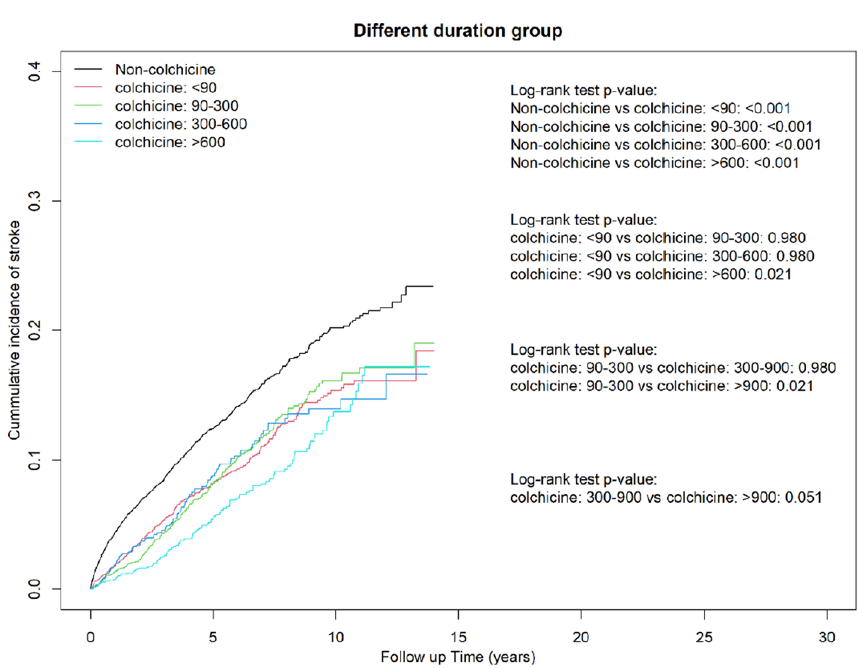
Figure 4. Cumulative incidence of stroke between groups with different colchicine use durations obtained using the Kaplan–Meier